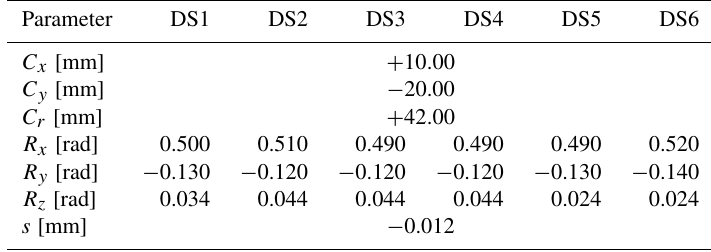
Table A2. Reference solutions for hole-pattern fit of test data sets.